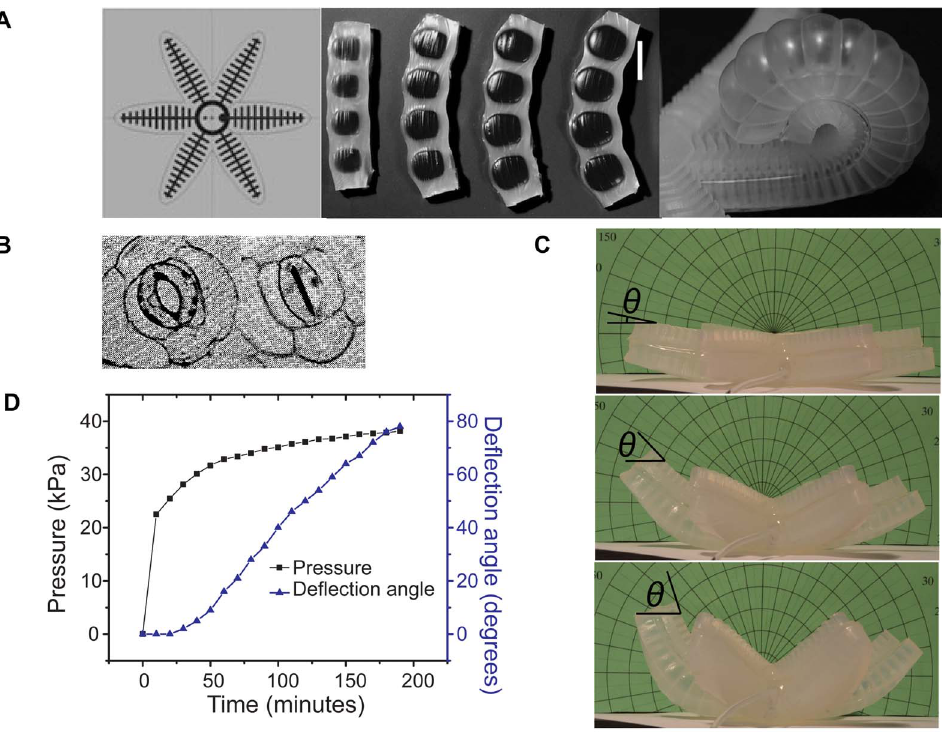
Figure 4. Bioinspired application of an osmotic pressure generator for actuation of a soft robot. A . Design concept of a previously described elastomeric soft robot whose arms curve and can grip objects in response to pressurization of parallel channels with boundaries of differing thickness. Adapted from [17]. B . Guard cells in their open and closed states. Thick interior walls make guard cells curl when osmotically pressurized, opening stomata. Adapted from [28]. C . Actuation of the soft robotic gripper used in this work in response to watering an attached osmotic pressure generator. The extent of deflection is shown after 1, 2, and 3 hours. D . System pressure and deflection angle (as defined in C) of the gripper as a function of time.